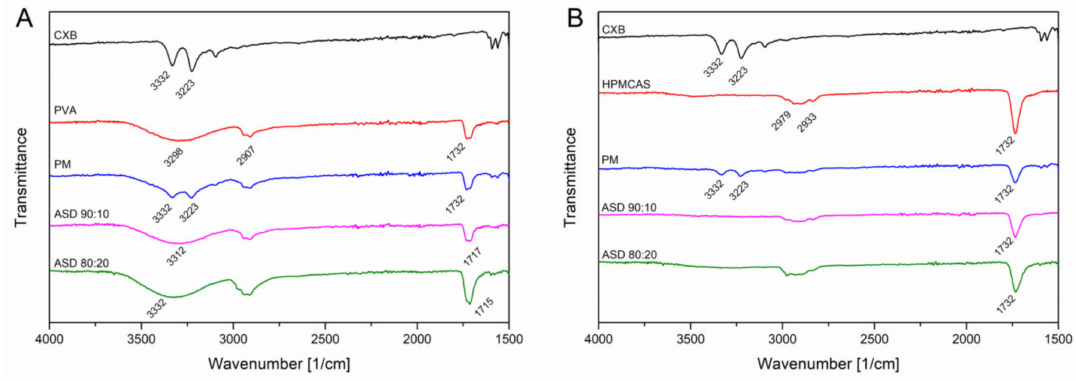
Figure 5. Fourier-transformed infrared spectra of CXB-PVA formulations ( A ) and CXB-HPMCAS formulations ( B